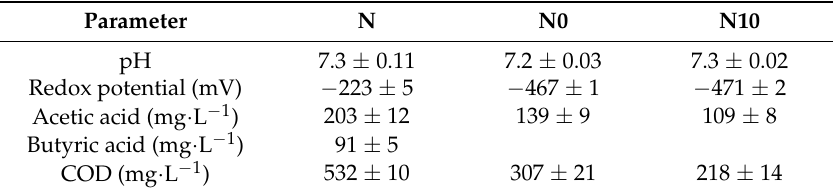
Table 1. Reactors analysis after BMP